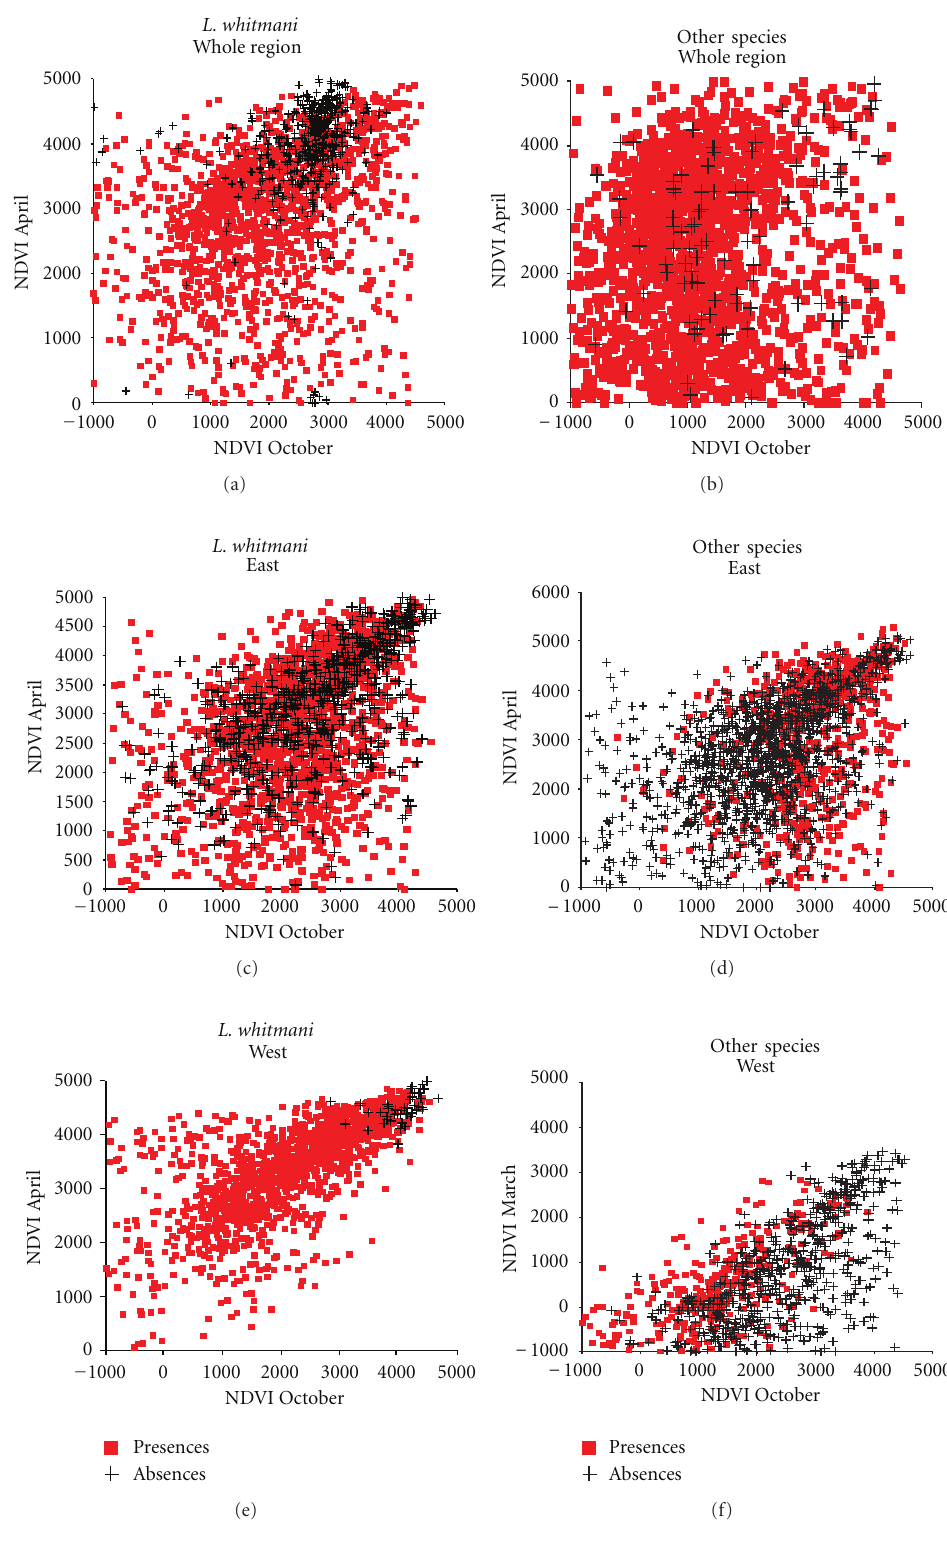
Figure 2: Presences and absences of Lutzomyia whitmani (a, c, e) and other species of Lutzomyia (b, d, f) in west, east, and center regions of the Amaraj´ı study area in Pernambuco, according to NDVI values October 2006 and March